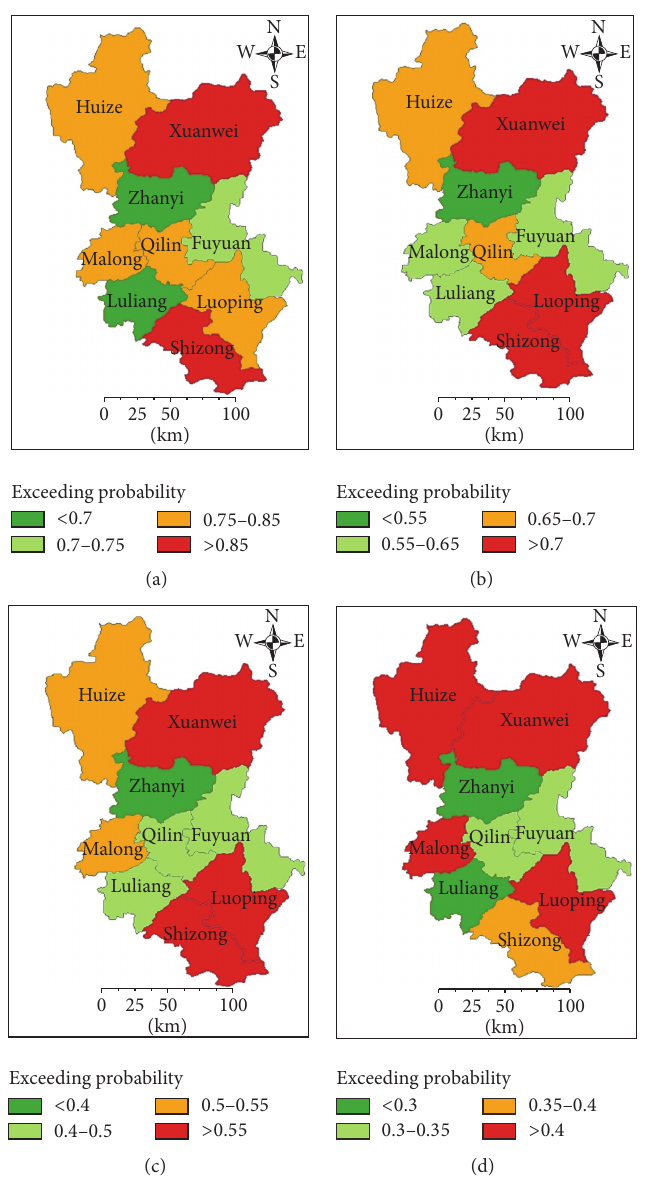
Figure 6: Maps of drought risk in